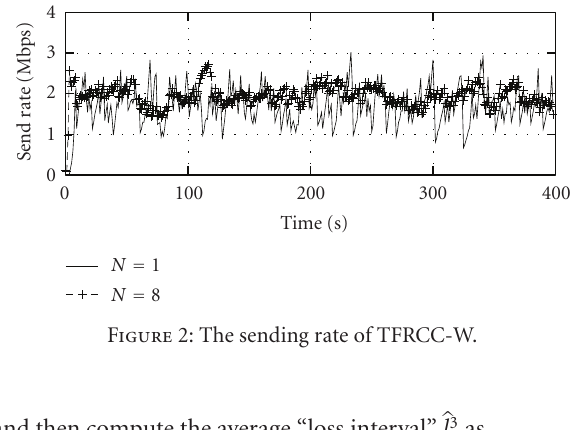
Figure 2: The sending rate of